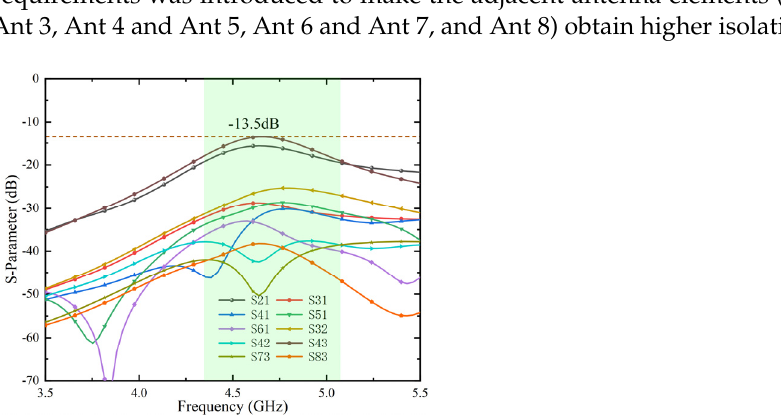
Figure 7. Transmission coefficients of MIMO antenna systems without decoupling.